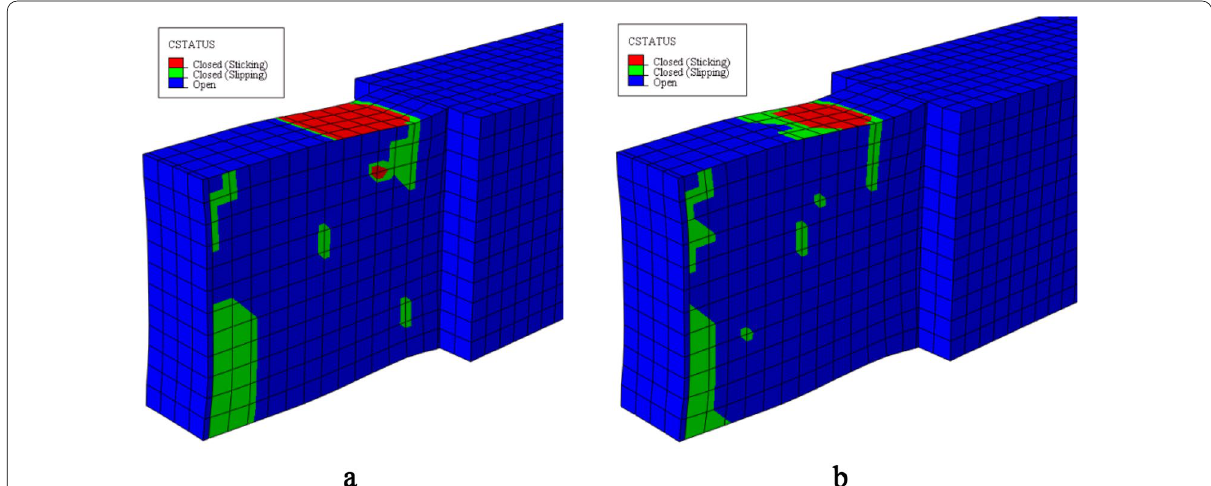
Fig. 32 Contact state of contact surface in the reverse unloading stage: a VC-FEM; b